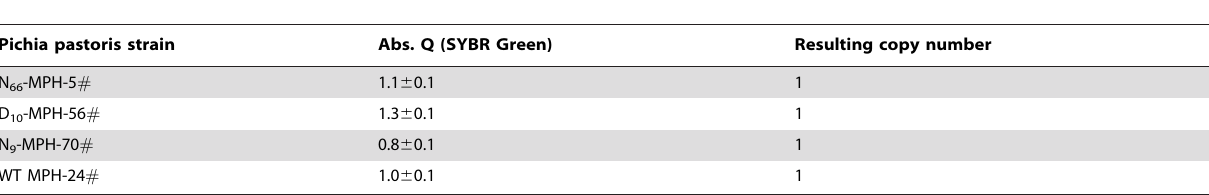
Table 1. The copy number calculation of WT and mutant MPH according to absolute (Abs.